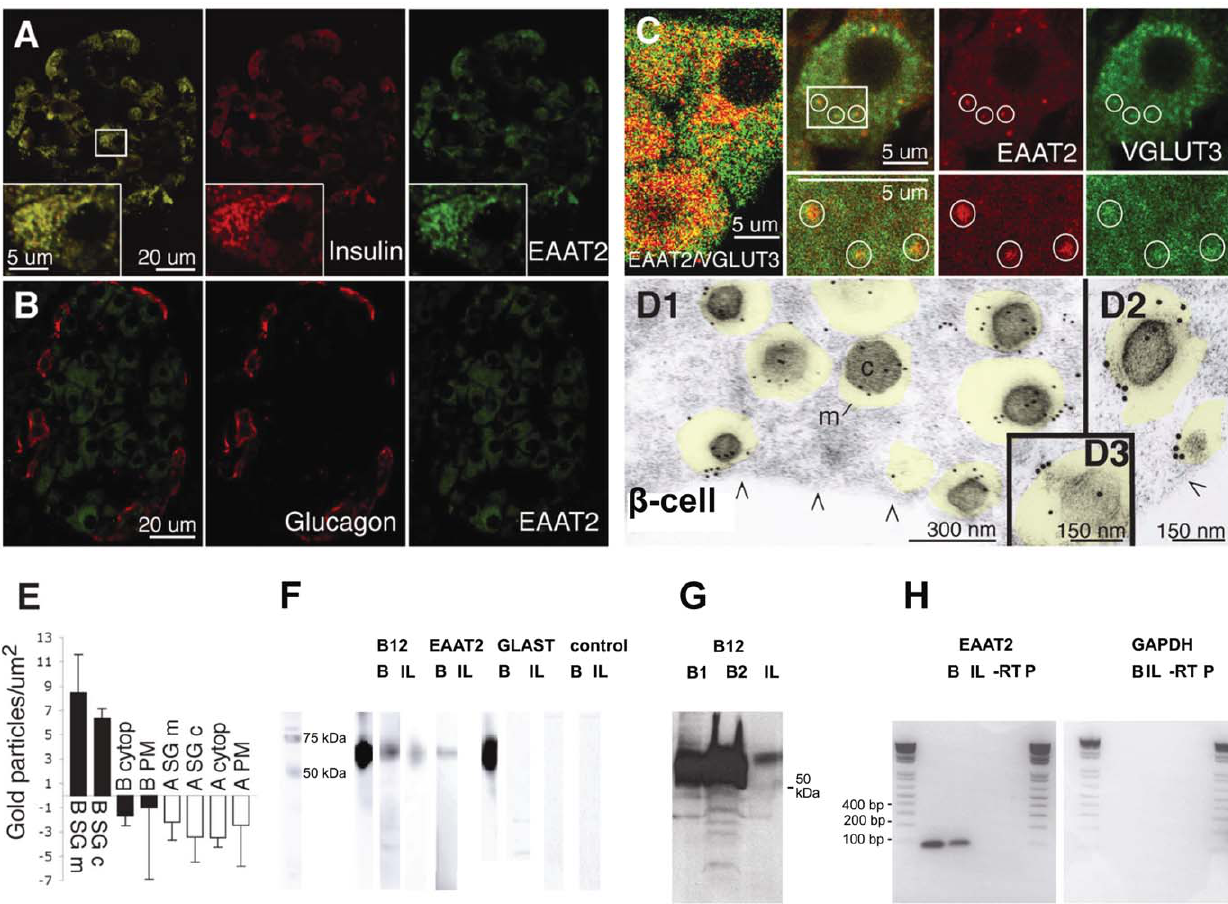
Figure 3. The glutamate transporter EAAT2 is selectively localized in b -cell secretory granules. (A–B) EAAT2 (green) co-localizes with insulin (red in A) in b -cells but not with glucagon in a -cells (red B). (C) EAAT2 (red) co-localizes partly with the vesicular glutamate transporter VGLUT3 (green). At higher magnification (right panels) it is evident that there are granules containing both EAAT2 and VGLUT3, some of which are indicated by circles. (D1–D3) Electron micrographs showing that EAAT2 immunogold particles are localized in secretory granules (transparent yellow) in three different b -cells. m, granule membrane. c, granule core. Arrowheads (/\), plasma membrane. E, Quantification of EAAT2 in different cellular compartments in a - and b -cells. The values are mean number of EAAT2 gold particles/ m m 2 6 SD in the various tissue compartments in 7 a - and 7 b - cells. The EAAT2 density is significantly higher in the membrane (B SG m) and core (B SG c) of the granules in b -cells, than in the cytosol of a - and b - cells (A cyto and B cyto), the plasma membrane of a - and b -cells (A PM and B PM) and the core (A SG c) and limiting membrane (A SG m) of a -cell granules (p , 0.001, Mann-Whitney-U test, two tails). (Background labelling was subtracted, see Methods. Except for B SG m and B SG c, all other compartments observed were at background levels.) The quantitative data presented are from one animal and similar results were obtained in two other animals. F, Western blots of isolated rat pancreatic islets (I) and rat brain tissue (B) using EAAT2 antibodies raised against both the C-terminal (B12) and the N-terminal (monoclonal (M)) parts. EAAT1 showed no band in islet tissue. Controls (C) without primary antibody showed no band. Note that the Westerns were run with several different homogenate concentrations, so that the lanes to be directly compared could mostly not be on the same membrane, however all membranes were run in the same set of experiments. (G) Western blot of isolated rat pancreatic islets (I), and rat brain tissue (2 separate brains, B 1 and B 2 ) all on the same membrane using EAAT2 antibodies raised against the EAAT2 C-terminal (B12). (H) RT-PCR of rat brain tissue (B) and isolated islets (I) in which there was a PCR signal for EAAT2 at about 100 bp (expected value), but not for human